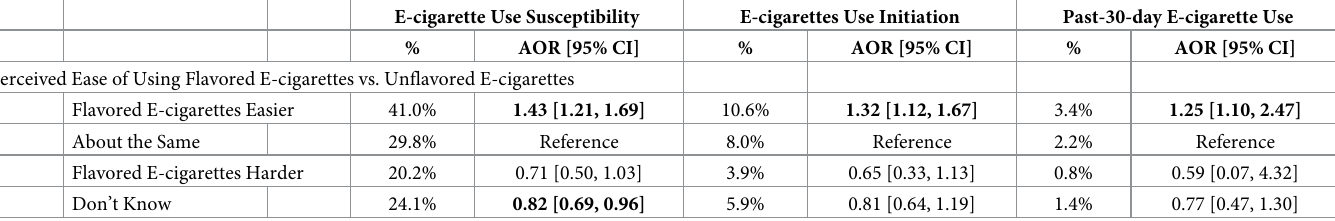
Table 2. Adjusted associations between perceived ease of using flavored e-cigarettes and e-cigarette use outcomes—PATH Study youth never tobacco users (aged 12–17) wave 1 and 2 surveys (n =